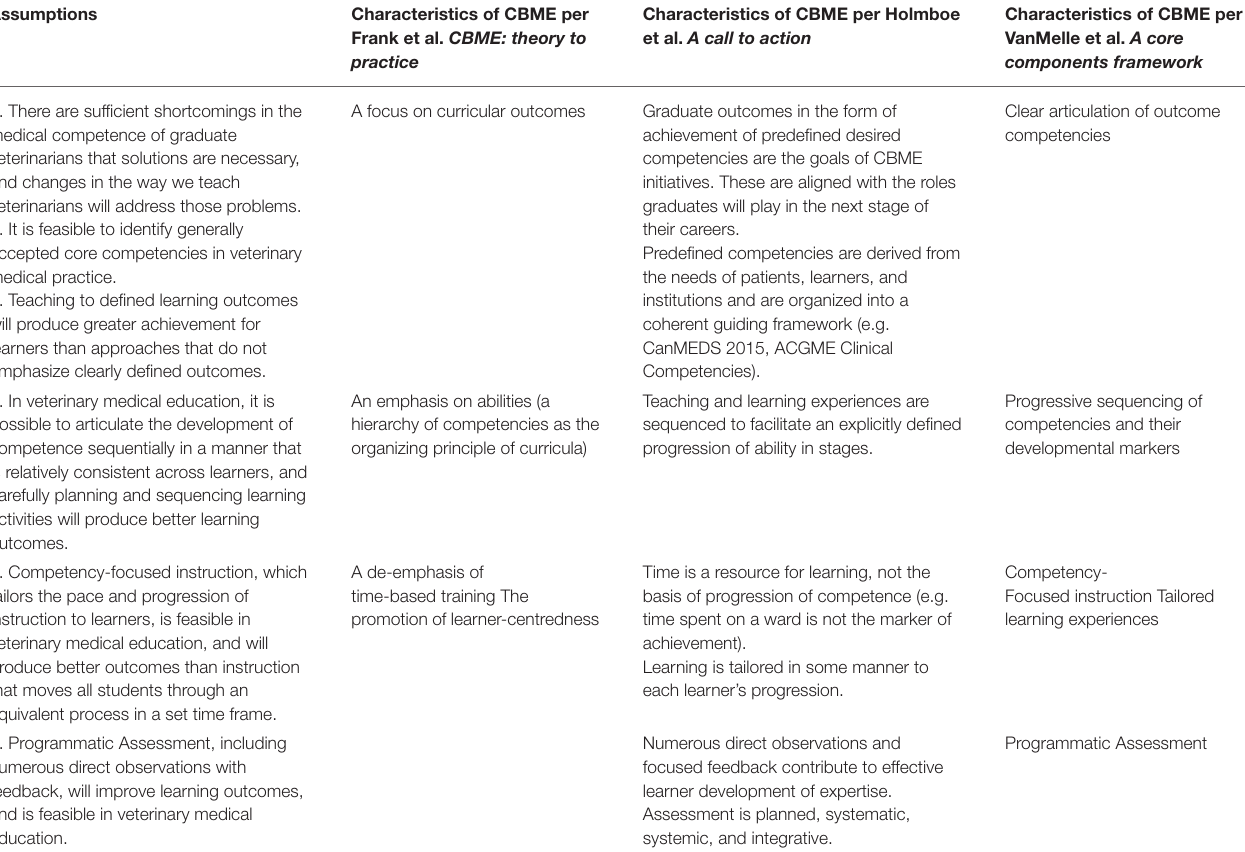
TABLE 1 | Underlying assumptions of a competency based approach and implications for instruction, assessment, and feasibility tied to characteristics of CBME as identified by Frank et al. s’ (4) Competency-based medical education: theory to practice , Holmboe et al. s’ (7) A call to action , and Van Melle et al. s’ (8) A core components framework .